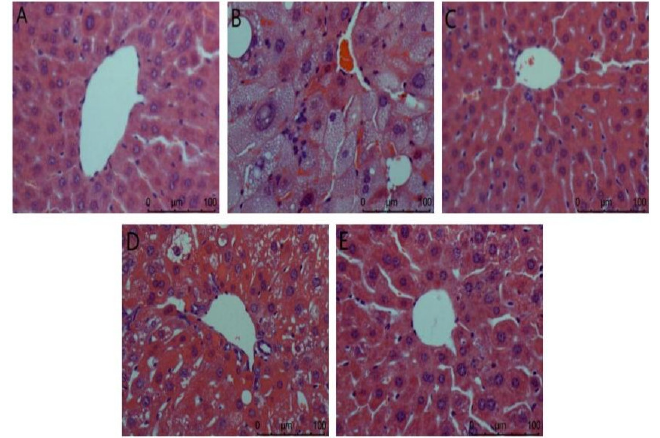
Figure 2. Liver biopsy analysis in mice. ( A ): Normal; ( B ): Model; ( C ): Positive control; ( D ): ACP low dose; ( E ): ACP high dose.